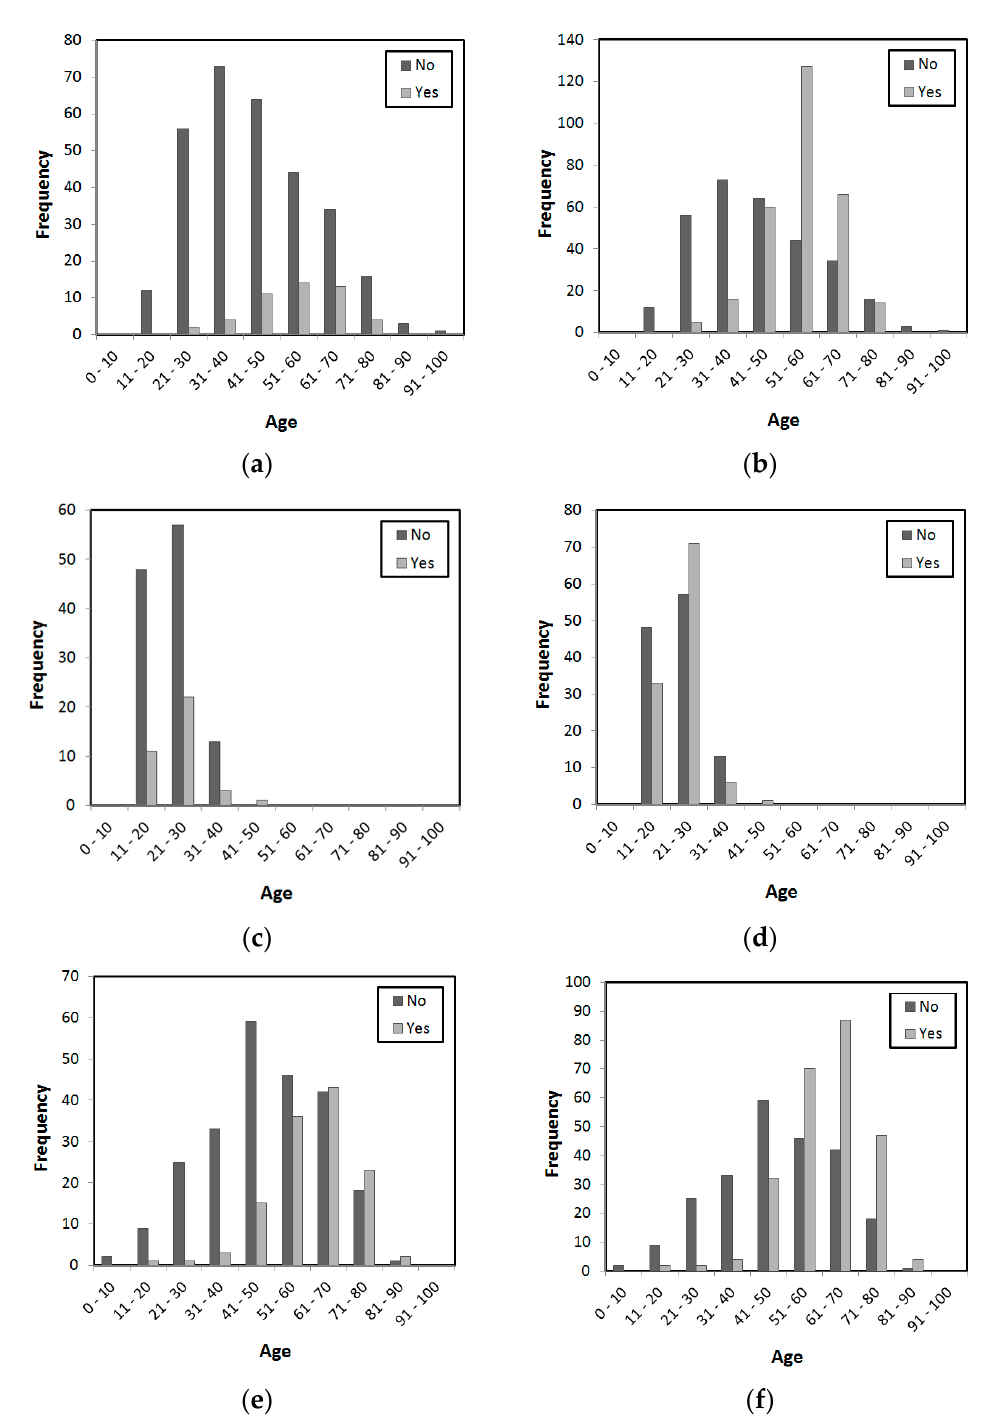
Figure 3. Attribute Age before and after SMOTE implementation are presented, respectively, for each dataset I ( a , b ); II ( c , d ); and, III ( e , f